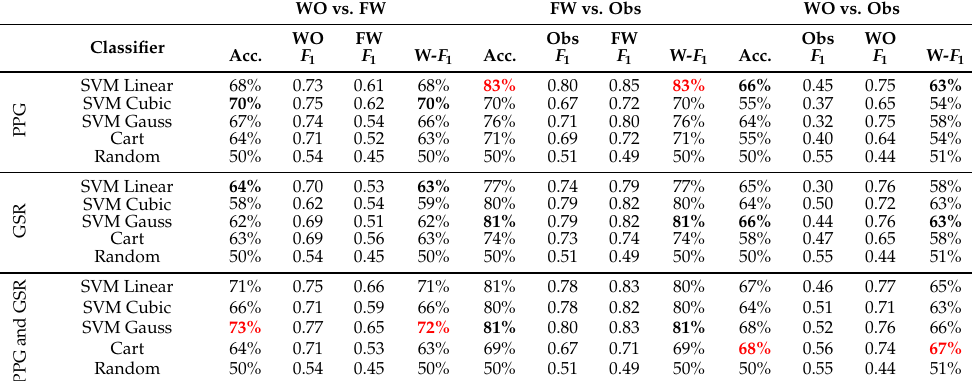
Table 9. Performance of the binary classifiers in discriminating walking tasks having similar walking pace considering the signals collected from older adults. Three tasks are compared: pure free walk FW, free walk before and after the collision avoidance zone WO and obstacle crossing Obs. The analysis are performed varying the feature set used (PPG, GSR or PPG and GSR) and adopting a LOSO validation strategy. Three performance metrics are reported: accuracy (Acc.), F1-score ( F 1 ) and weighted F1-score (W- F 1 ). The W- F 1 values in bold represent the best performances achieved for each feature set considered, while in red is highlighted the best accuracy at all. WO vs. FW FW vs. Obs WO vs. Obs